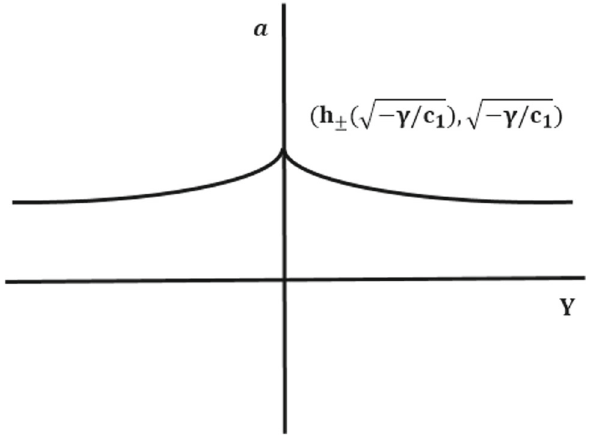
Fig. 4 Graph of the warp factor as a function of Y , for λ = 3 /